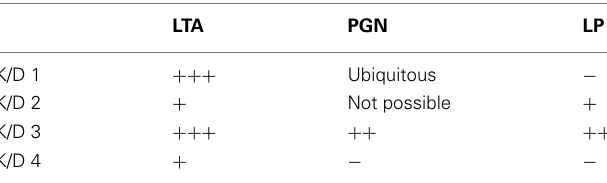
Table 7 | Fulfillment of the four K/D criteria for LTA, PGN, and LP (criteria: 1–5 publications: + ; 6–10 publications: ++ ; > 10